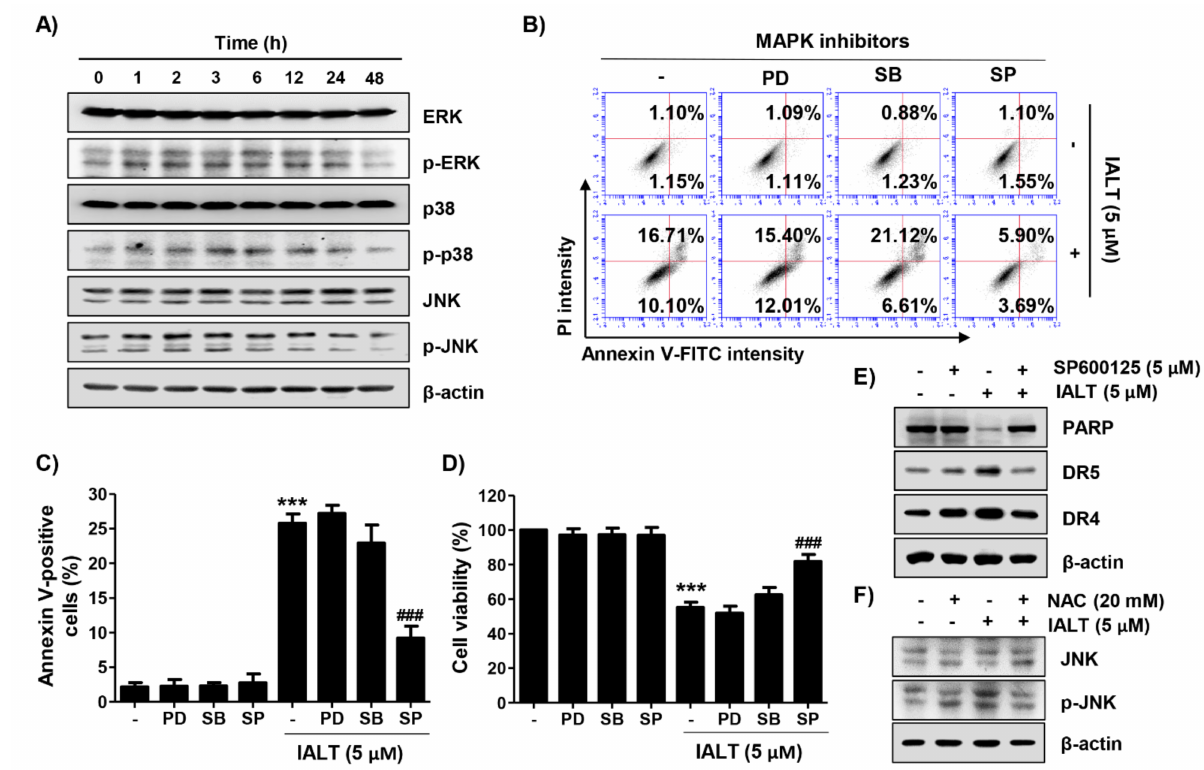
Figure 4. Activation of the mitogen-activated protein kinases (MAPK) signaling pathway by IALT in Hep3B cells. Cells were treated with 5 µ M IALT for the indicated times ( A ), or pre-treated with MAPK inhibitors [25 µ M PD98059 (PD), 2.5 µ M SB203580 (SB) or 5 µ M SP600125 (SP)] or 20 mM NAC for 1 h, and then treated with 5 µ M IALT for another 48 h ( B–F ). ( A ) The expression of extracellular-signal-regulated kinase (ERK), p38, and c-Jun N-terminal kinase (JNK) proteins and their phosphorylated forms were evaluated by Western blot analysis. The immunoblot for β -actin served as a loading control. ( B , C ) Quantitative analysis of apoptosis induction by annexin V and PI staining was performed. ( B ) Representative profiles of flow cytometry results are presented. ( C ) The percentage of apoptotic cells was expressed as a percentage of the total number of annexin V-positive cells. ( D ) Cell viability was measured by the MTT assay. ( E , F ) The results of Western blot analysis of the indicated proteins are presented. The immunoblot for β -actin served as a loading control. ( C , D ) Data are expressed as the mean ± SD (*** p < 0.001 compared to untreated cells. ### p < 0.001 compared to 5 µ M IALT-treated